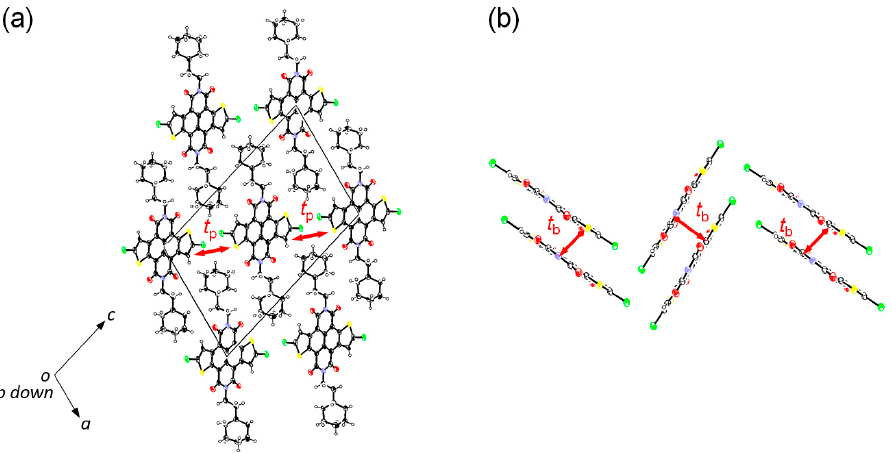
Figure 5. Crystal structure of 4 : ( a ) b -axis projection and ( b ) side view of stacking columnar structure. Calculated transfer integrals of LUMOs, t p and t b , are 8 and 105 meV,